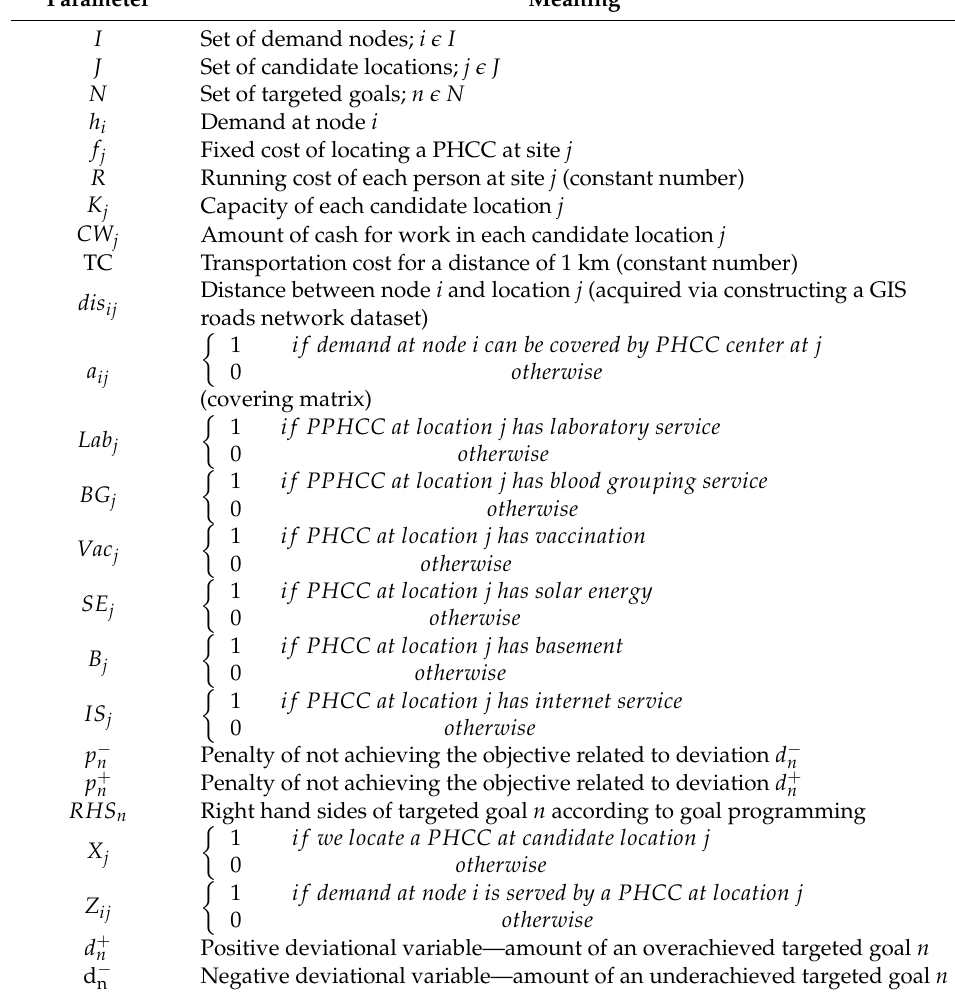
Table 1. Meanings of model parameters and